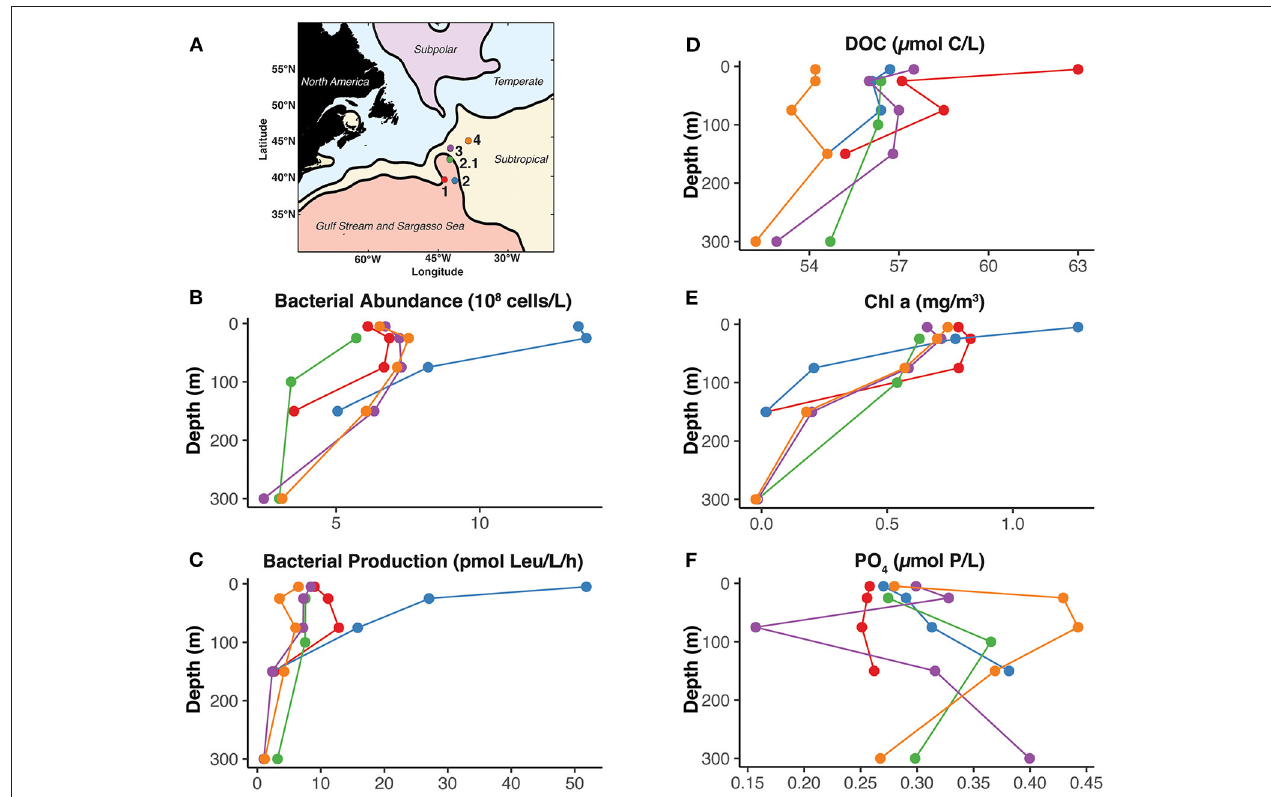
FIGURE 1 | Geographic, chemical, and biological context of the NAAMES4 expedition. (A) The locations of the five stations are shown within the oceanographic regions of the North Atlantic based on mean dynamic topography as defined by Della Penna and Gaube (2019). (B–F) Depth profiles of core biological and chemical parameters from each station. Only depths where TRCs were also collected are shown. The color of the profile corresponds to the color of the station in (A) . The full presentation, explanation, and analysis of these data can be found in Baetge et al.